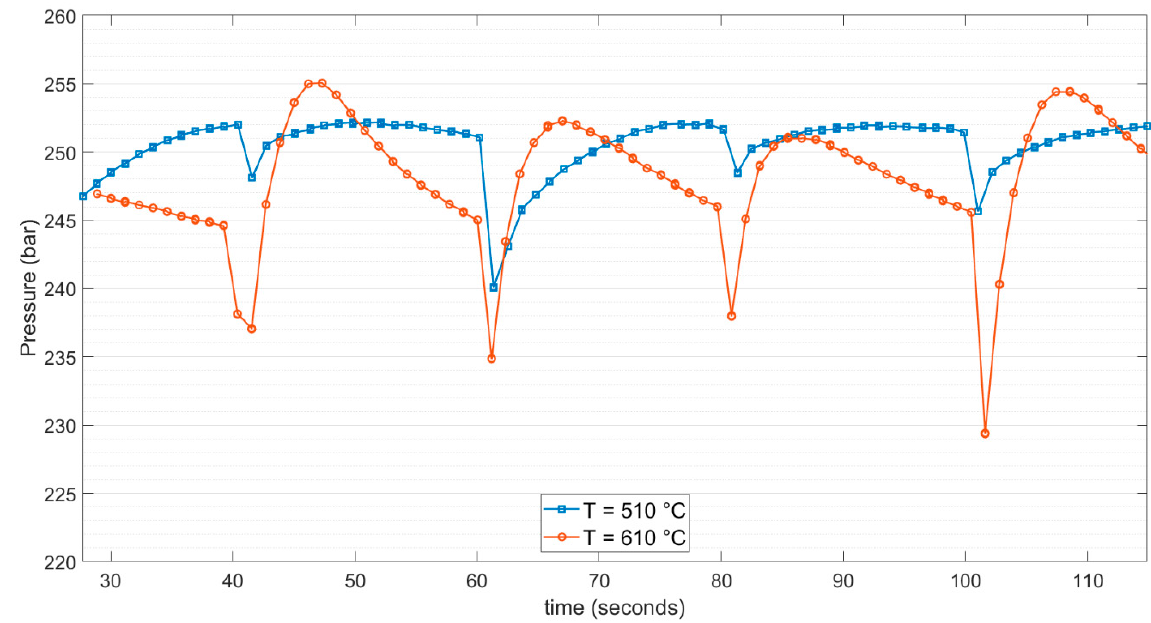
Figure 8. Comparison of pressure recordings within the system at different setpoint temperatures.